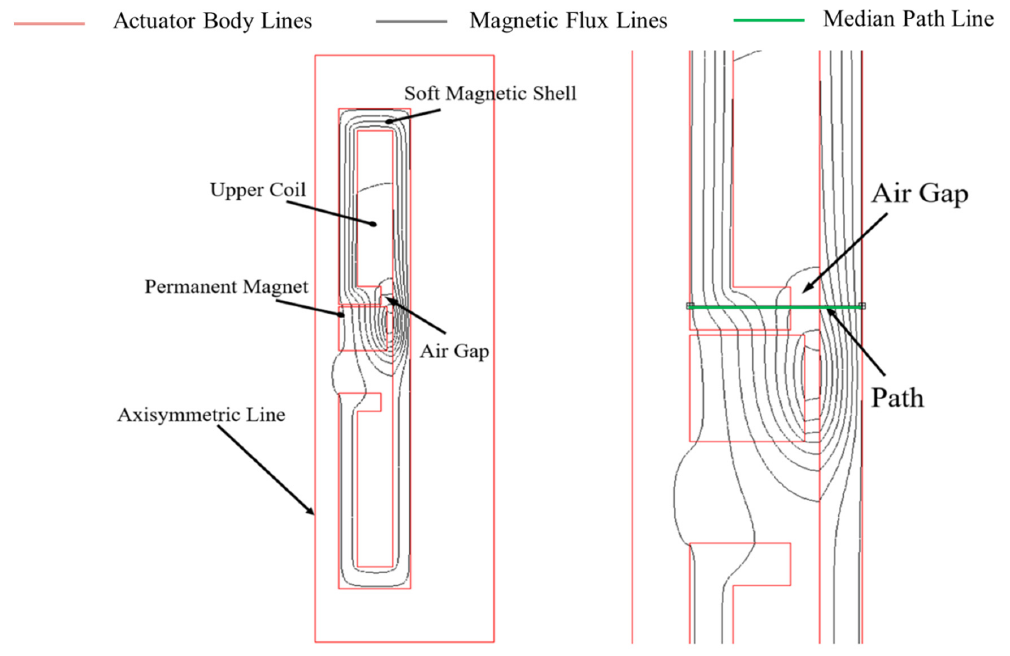
Figure 6. Contour plot of the magnetic flux line density across the actuator body with the imaginary median path shown across the air gap in the zoomed-in (right side) figure.